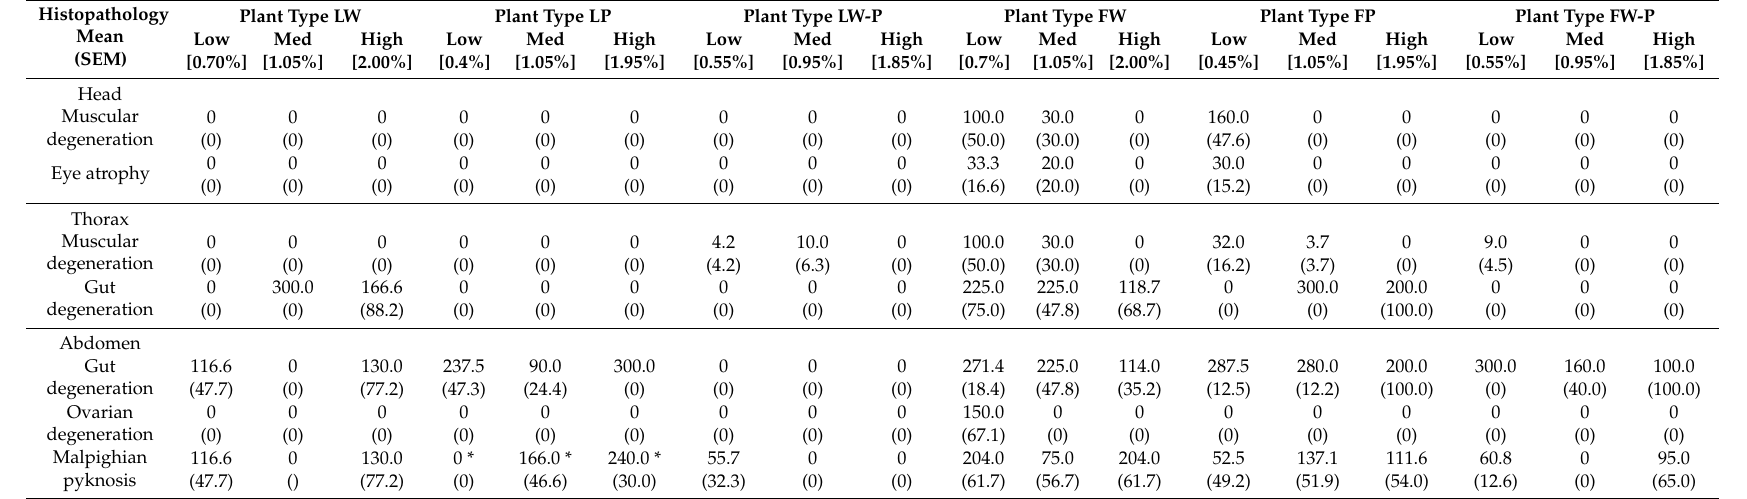
Table 6. Histopathological scores in the mosquitoes treated with the six types of essential oils of A. conyzoides and in those that went